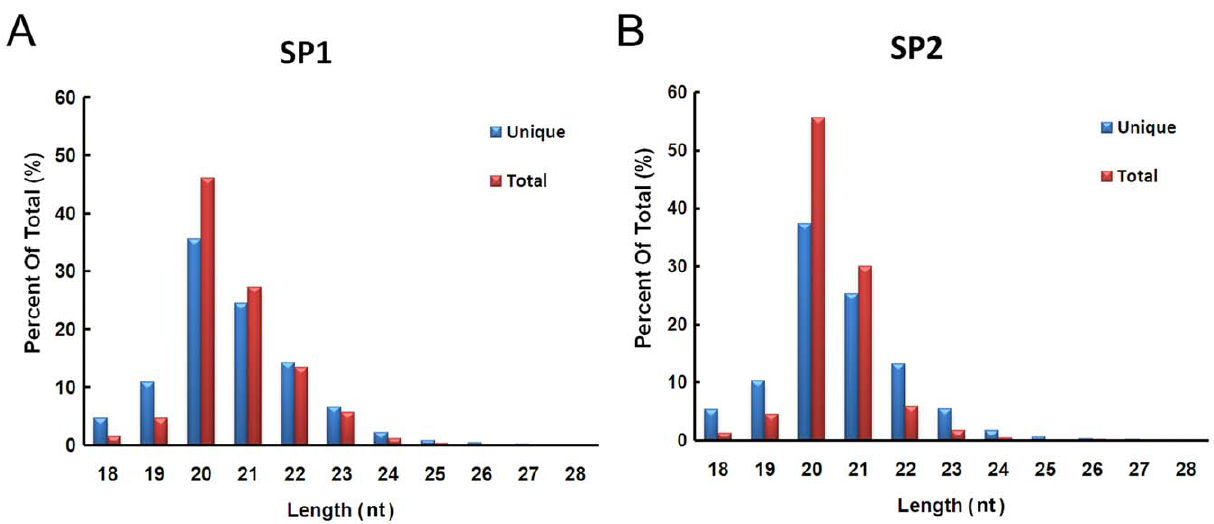
Figure 4. Length distribution of the small RNAs perfectly matched the draft of S.japonicum genome. A. Length distribution of reads from the SP1 and B. SP2 libraries. Both at unique and total levels, the 20-nt reads were predominant in the two libraries, followed by the 21-nt